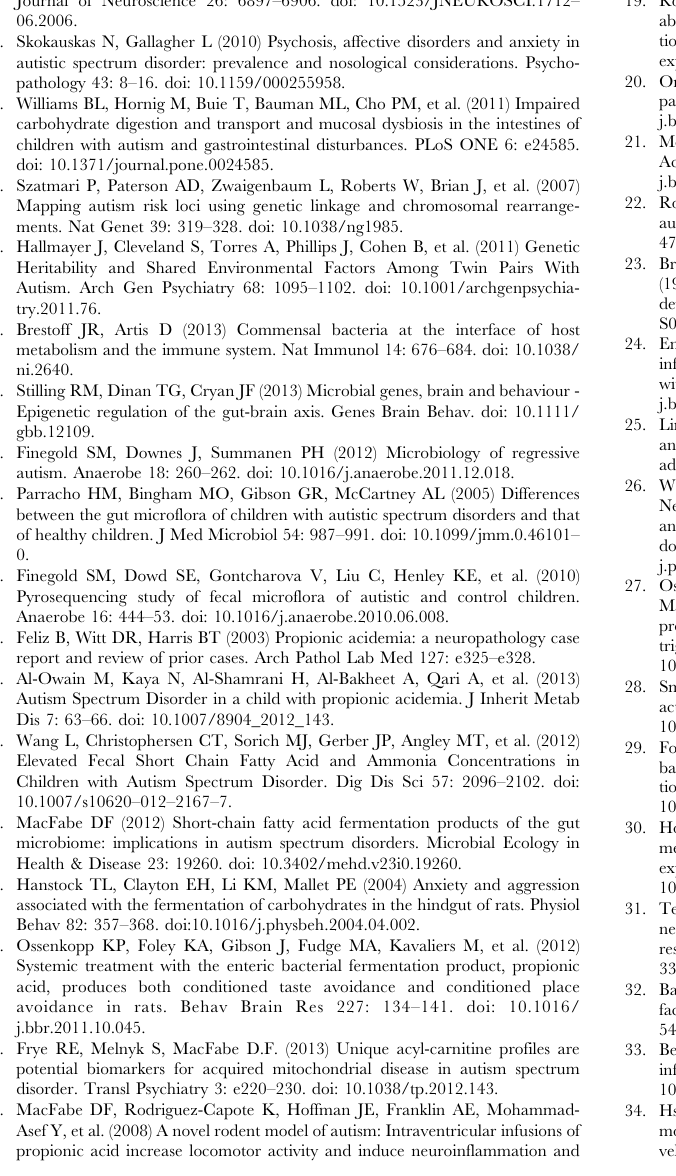
S.E.M. Refer to Table 1 for group designations and sample sizes. * p ,